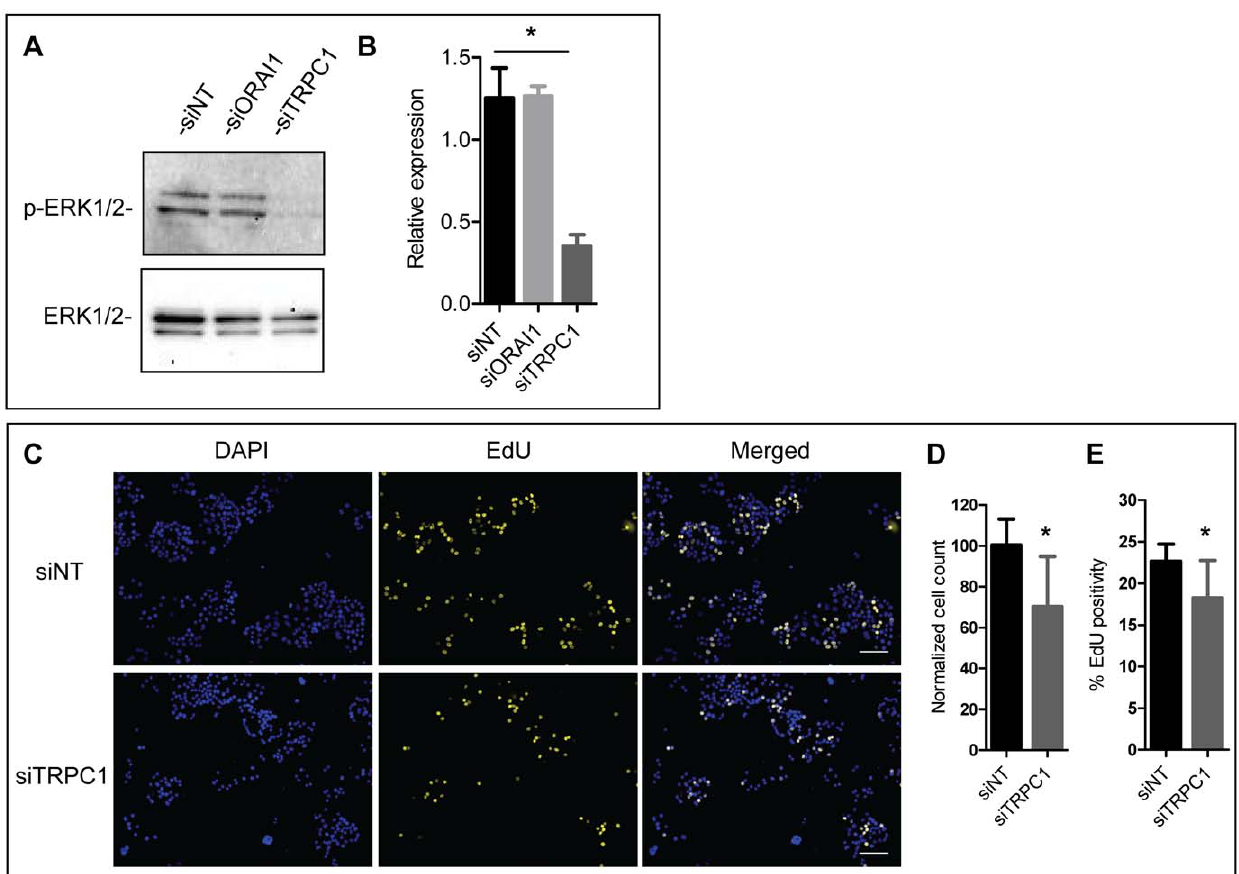
Figure 8. Effect of TRPC1 and ORAI1 silencing on constitutive ERK1/2 activity and cell proliferation. A ) Representative immunoblot showing constitutive phosphorylation and total expression of ERK1/2 in MDA-MB-468 cells with ORAI1 or TRPC1 silencing. B ) Densitometric data was obtained from the pooled data (three independent immunoblots) and shows ERK1/2 phosphorylation relative to total ERK1/2 expression; * P , 0.05 (one-way ANOVA with Bonferroni post-tests). C ) DAPI (cell number) and EdU staining (showing cells in S-phase of the cell cycle). D ) Quantitation of the average cell count and ( E ) EdU positivity for nine wells from three independent experiments.* P , 0.05 (unpaired t-test). All graphs show mean 6 S.D. Scale bar represents 100 m m.